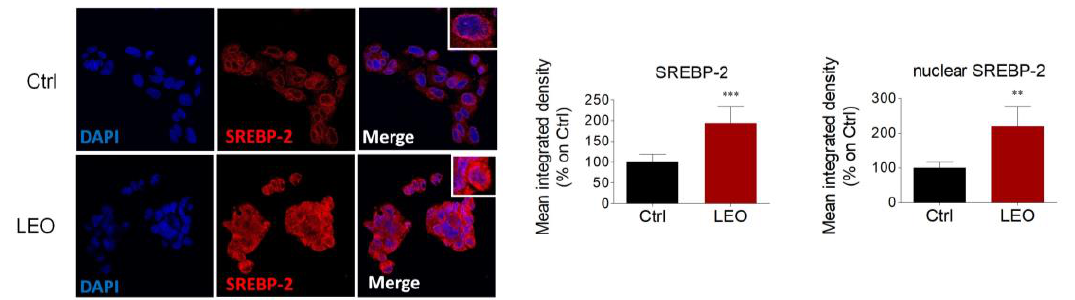
Figure 5. LEO induces SREBP-2 expression and nuclear translocation in HepG2 cells. Left panel: representative immunofluorescence of SREBP-2 (red) upon 24 h of LEO administration (0.005%). DAPI (blue) was used to counterstain the nuclei. Right panel: quantitative evaluation of the total and nuclear SREBP-2 protein fluorescence intensity. n = 7 different experiments. Data represent means ± SD. Statistical analysis was assessed using the unpaired Student’s t -test. ** p < 0.01; *** p < 0.001.